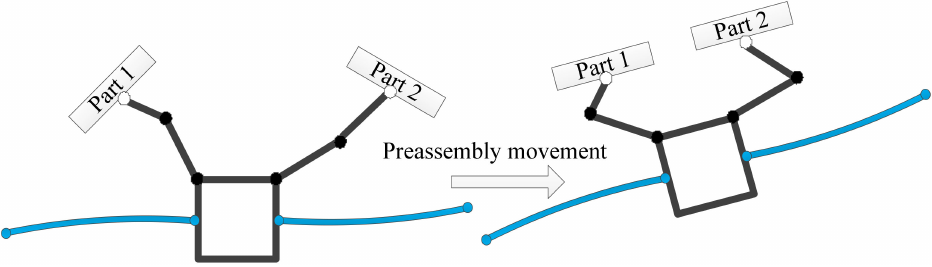
Figure 4. Preassembly to achieve the defined